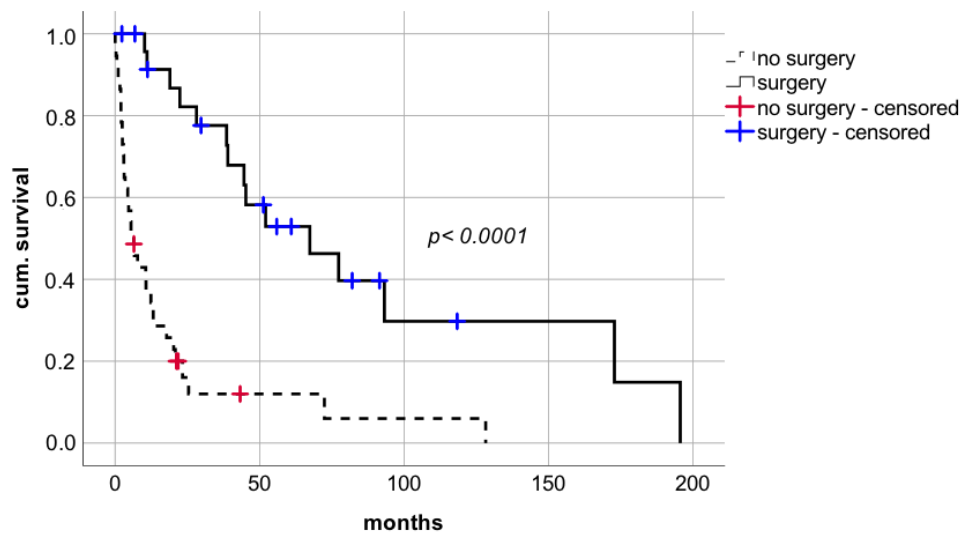
Figure 3. Comparison of patients with or without surgical approach after diagnosis of de novo lung carcinoma after liver transplantation.